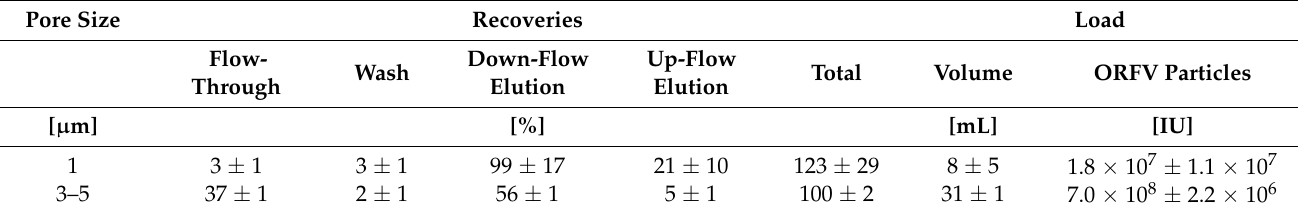
Table 1. Overview of recoveries and load volumes for infective ORFV from SXC experiments with regenerated cellulose membranes as stationary phases. Both column types (1 µ m and 3–5 µ m pore diameter) were single-use. They consisted of ten stacked membranes, each 13 mm in diameter. Each run consisted of a loading step (the flow-through is analyzed), a wash step, and two elution steps, i.e., a down-flow and an up-flow elution. The down-flow elution was performed in direction of flow, while the up-flow elution was